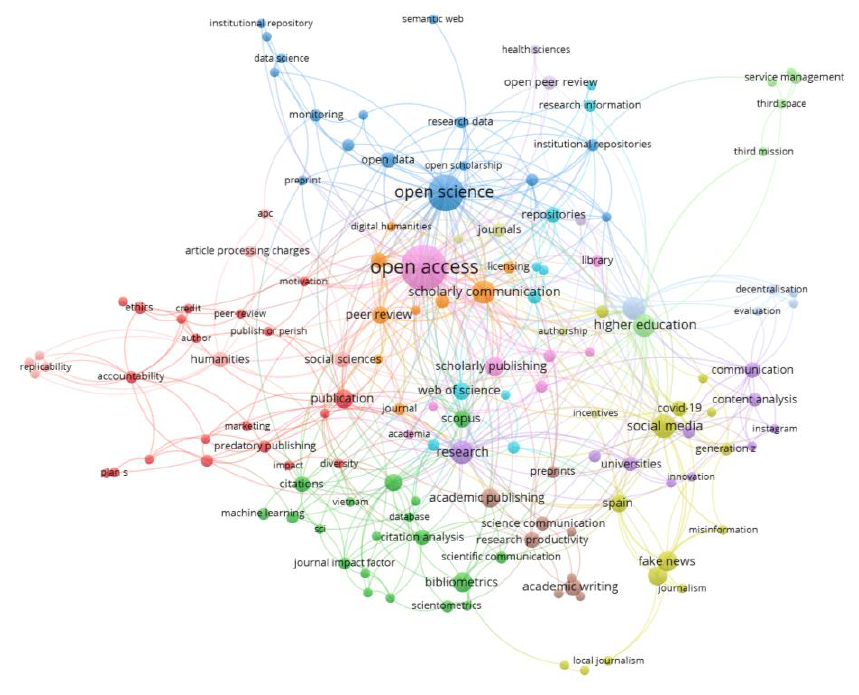
Figure 6. Top keyword network (n = 141, occurrence > 2) in the period 2018–2022. Source: VOSViewer. Table 13. Left: number of co-authors and documents. Right: authors with a total link strength >=10. Nr. Nr. of Authors